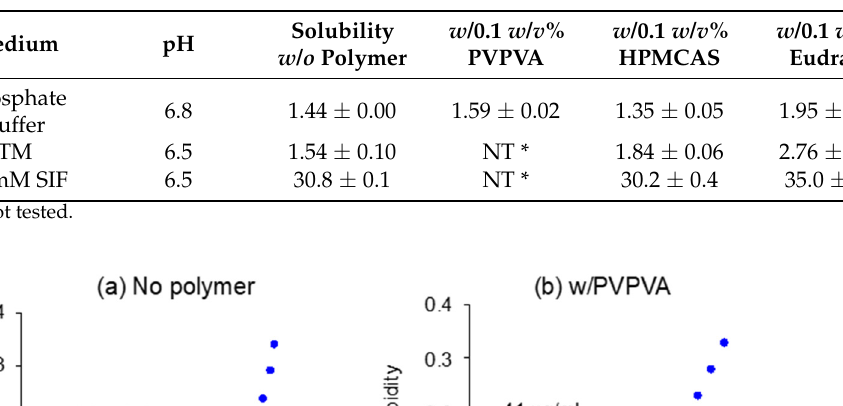
Figure 1. pH-solubility profile of NFT. ( ○ ) Buffered solutions, ( ■ ) 3 mM SIF, and ( ■ ) 15 mM SIF. Table 1. Solubility of NFT in polymer solutions ( μ g/mL). Table 1. Solubility of NFT in polymer solutions ( µ g/mL).